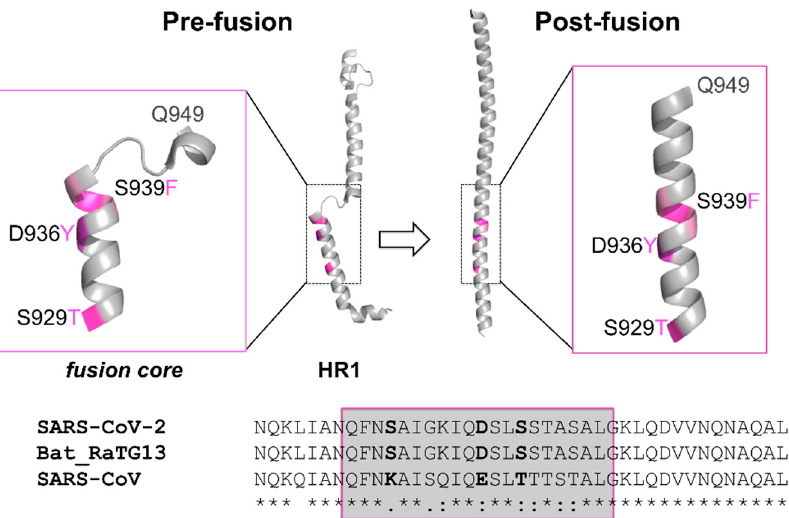
Figure 1. Structural and sequence location of the reported mutations. Top: Cartoon representation of SARS-CoV-2 S protein HR1 and its fusion core (insets) in the pre-fusion and post-fusion conformations (PDB IDs: 6VSB and 6LXT). Discussed mutations are colored in purple and labelled. Q949, at the end of the fusion core, is also labeled. Bottom: Sequence alignment of the HR1 fusion core (framed) and 10 residues up-stream and down-stream in the S protein of SARS-CoV-2, bat coronavirus RaTG13 (protein_ID: QHR63300.2), and SARS-CoV (protein_ID: AAP13441.1).